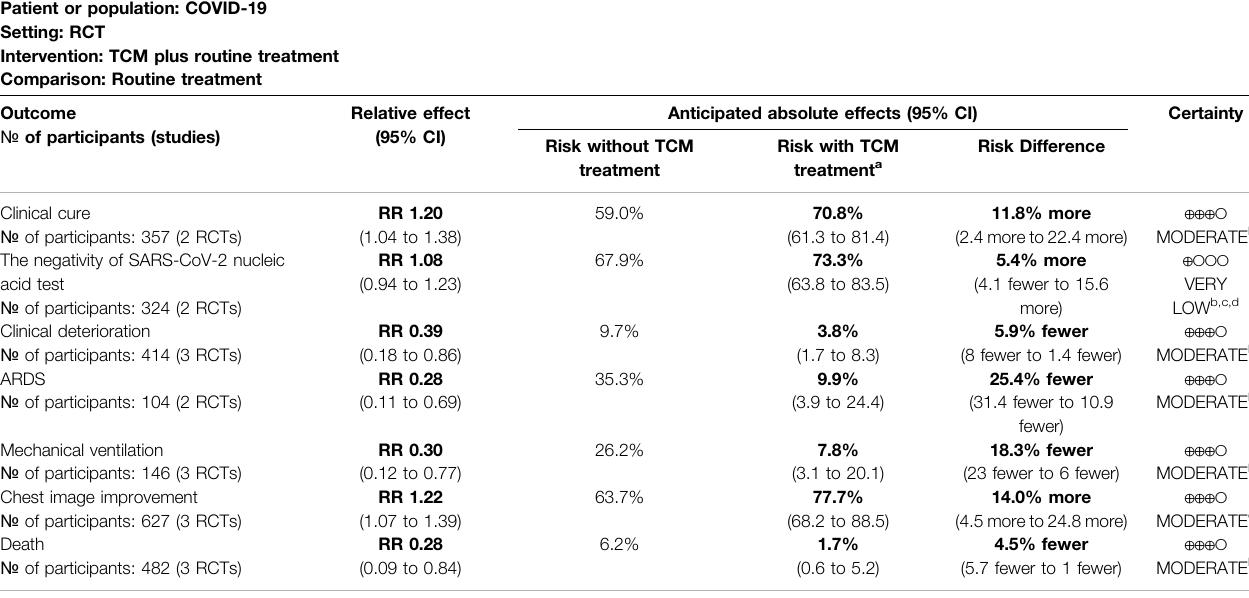
TABLE 4 | Summary of fi ndings. TCM plus routine treatment compared to standard treatment for COVID-19 Patient or population: COVID-19 Setting: RCT Intervention: TCM plus routine treatment Comparison: Routine treatment Outcome № of participants